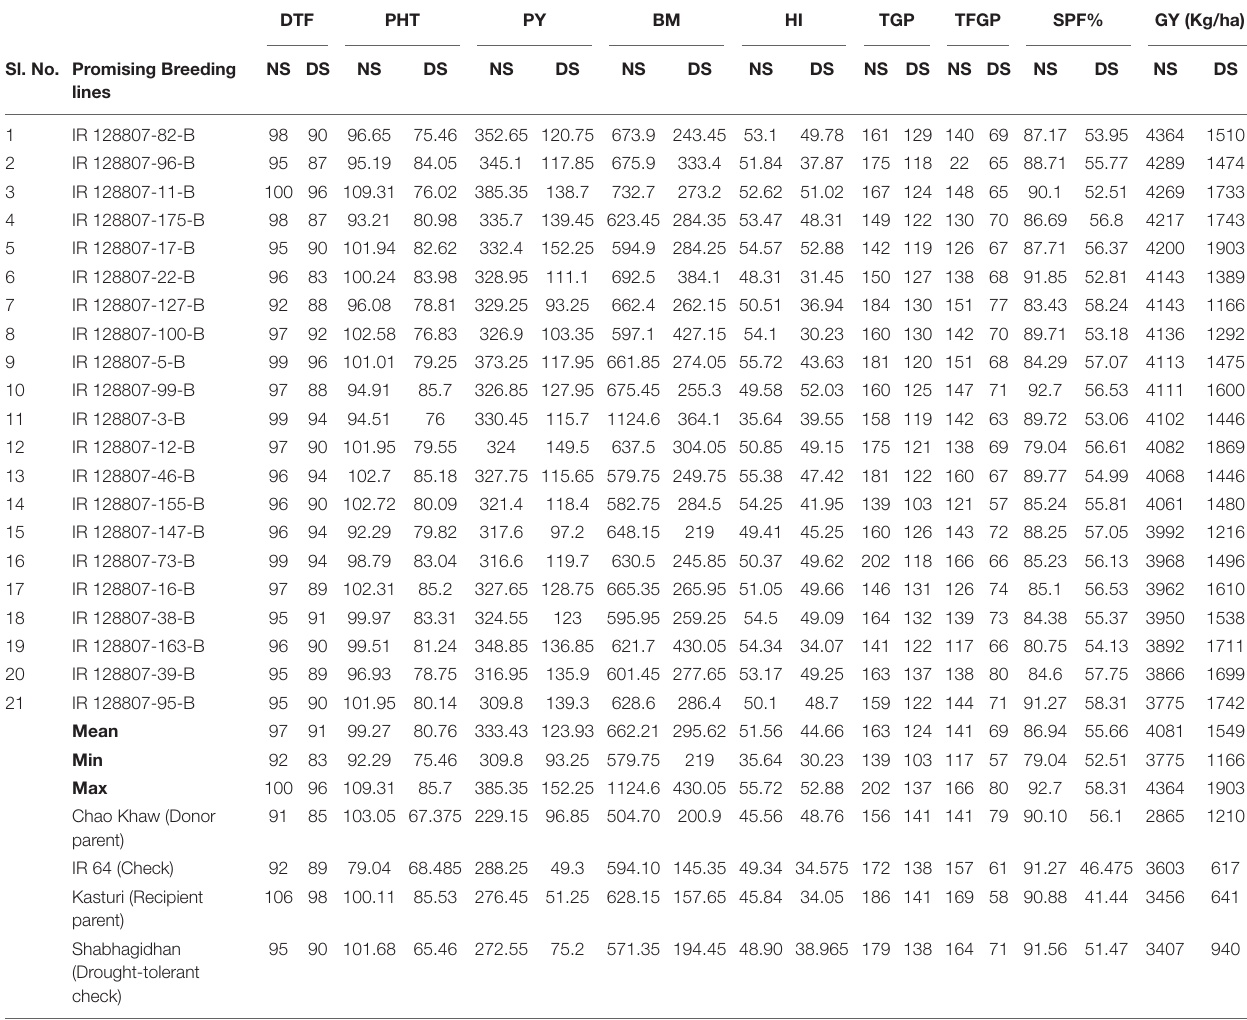
TABLE 3 | Promising high-yielding breeding lines identified under both non-stress and drought-stress conditions of 2015 WS and 2016 WS with better drought tolerance over the popular drought-tolerant check Shabhagidhan and drought-tolerant donor parent Chao Khaw. DTF PHT PY BM HI TGP TFGP SPF% GY